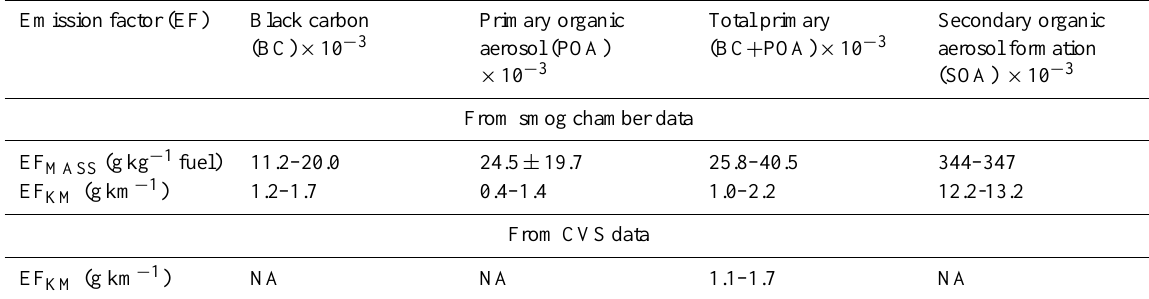
Table 4. Range of emission factors for carbonaceous aerosol and secondary organic aerosol formation for a Euro 5 gasoline light-duty vehicle calculated from smog chamber data and particulate matter (PM) from VELA (CVS) data. The range of observed values is